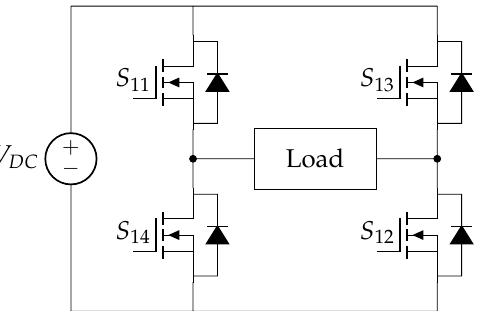
Figure 5. The topology of a full-bridge DC/AC converter. When actively operated, only one semiconductor in each leg is activated, being four, the potential states of the power converter in a phase-shifting control. Figure 6 illustrates the operation modes. In Figure 7, we have plotted the output voltage V out of the converter with a phase-shift control.